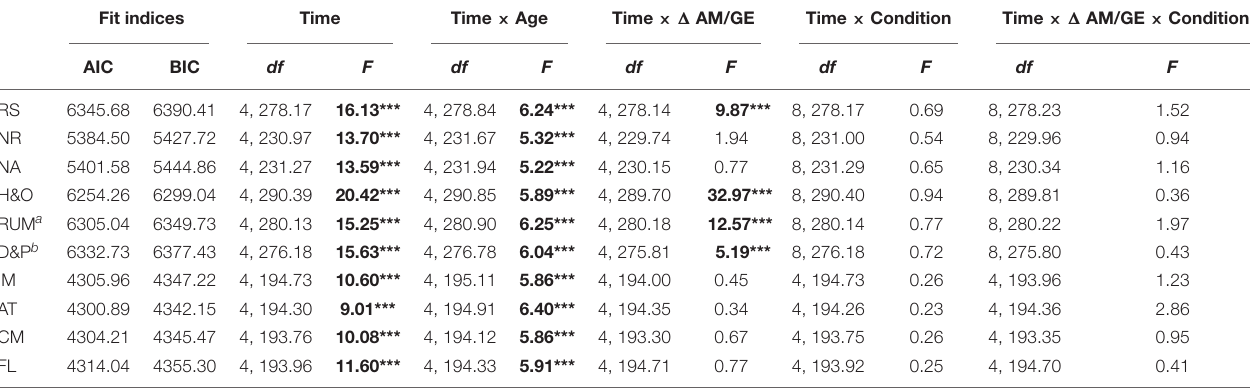
TABLE 5 | The effect of condition on depressive symptoms over time moderated by action mechanisms or game engagement using mixed effects